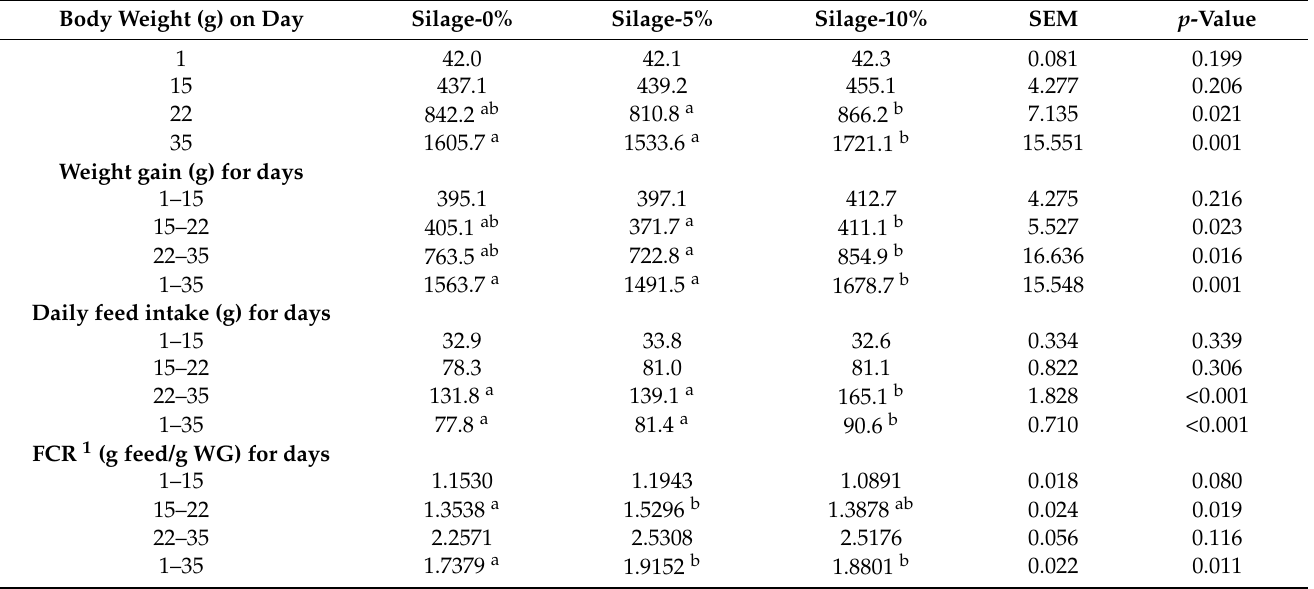
Table 3. Effect of silage supplementation on broiler performance parameters.